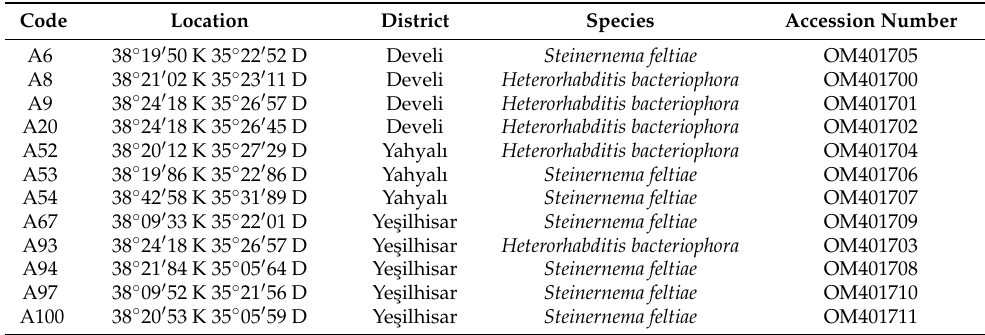
Table 3. Entomopathogenic nematode isolates found, with the indication of the locality and internal transcribed spacer (ITS) sequence